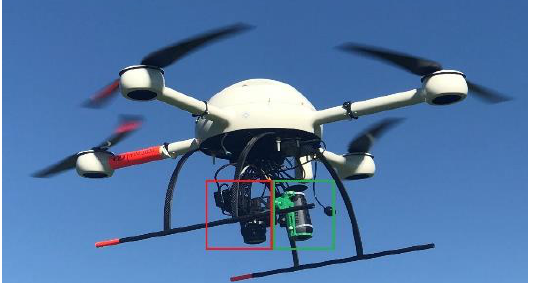
Figure 2a. A photo of our UAS with an RGB camera and a thermal sensor attached.